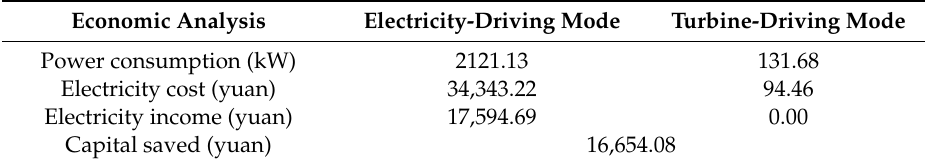
Table 4. Economic analysis of electricity-diving mode and turbine-driving mode.